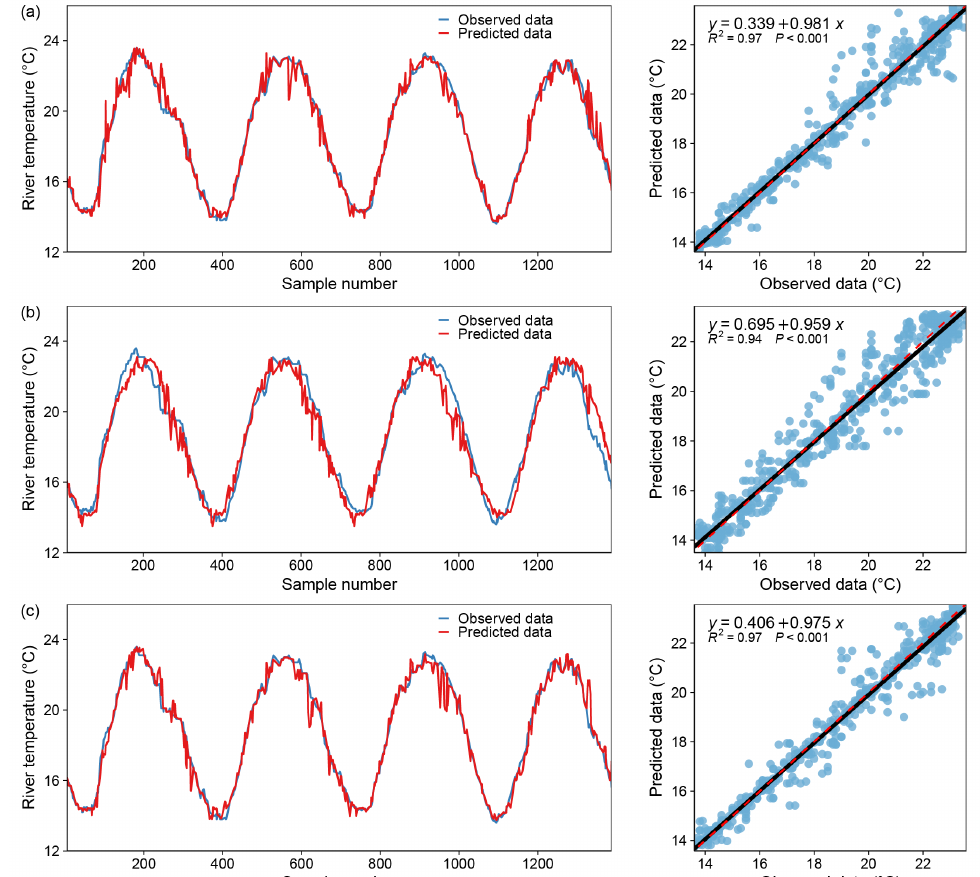
Figure 9. Model fitting results—GradientBoosting Regressor, blue dot: X coordinate (observed data), Y coordinate (predicted data) ; black line: y = x ; red dotted line: the regression curve of the blue dots. ( a ) only one input variable (DOY), ( b ) with two input variables (DOY and Flow), ( c ) with all variables. Table 4. Performances of GradientBoosting Regressor in modeling water temperature (WT: ◦ C), GB1: